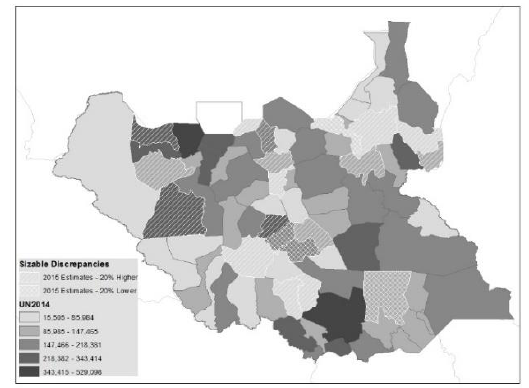
Figure 1. Comparison of 2014 UN OCHA Population Estimates with 2015 WorldPop